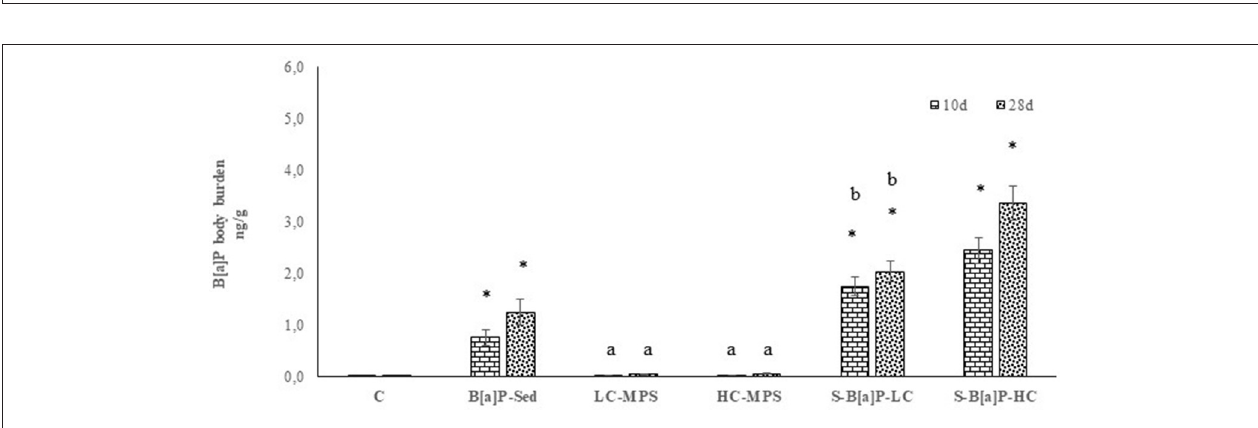
FIGURE 4 | Benzo(a)pyrene body burden accumulation in whole body of H. diversicolor exposed to uncontaminated sediments (C), D sediments spiked with 1 mg/L B[a]P (S-B[a]P), sediments spiked with 200 and 2000 particles/kg virgin PVC (LC-MPS, HC-MPS) and sediments with B[a]P spiked microplastic particles (B[a]P-LC: 200 particles/kg.; B[a]P-HC: 2000 particles/kg). Data are expressed as mean values ± standard deviation, n = 6. Different letters indicate significant differences between groups of means ( post-hoc